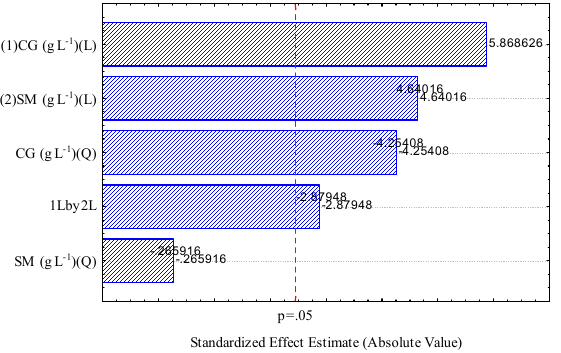
Figure 4. Pareto chart for applying the response surface methodology (RSM) model in the hydrogen production of crude glycerol (CG) and swine manure (SM).